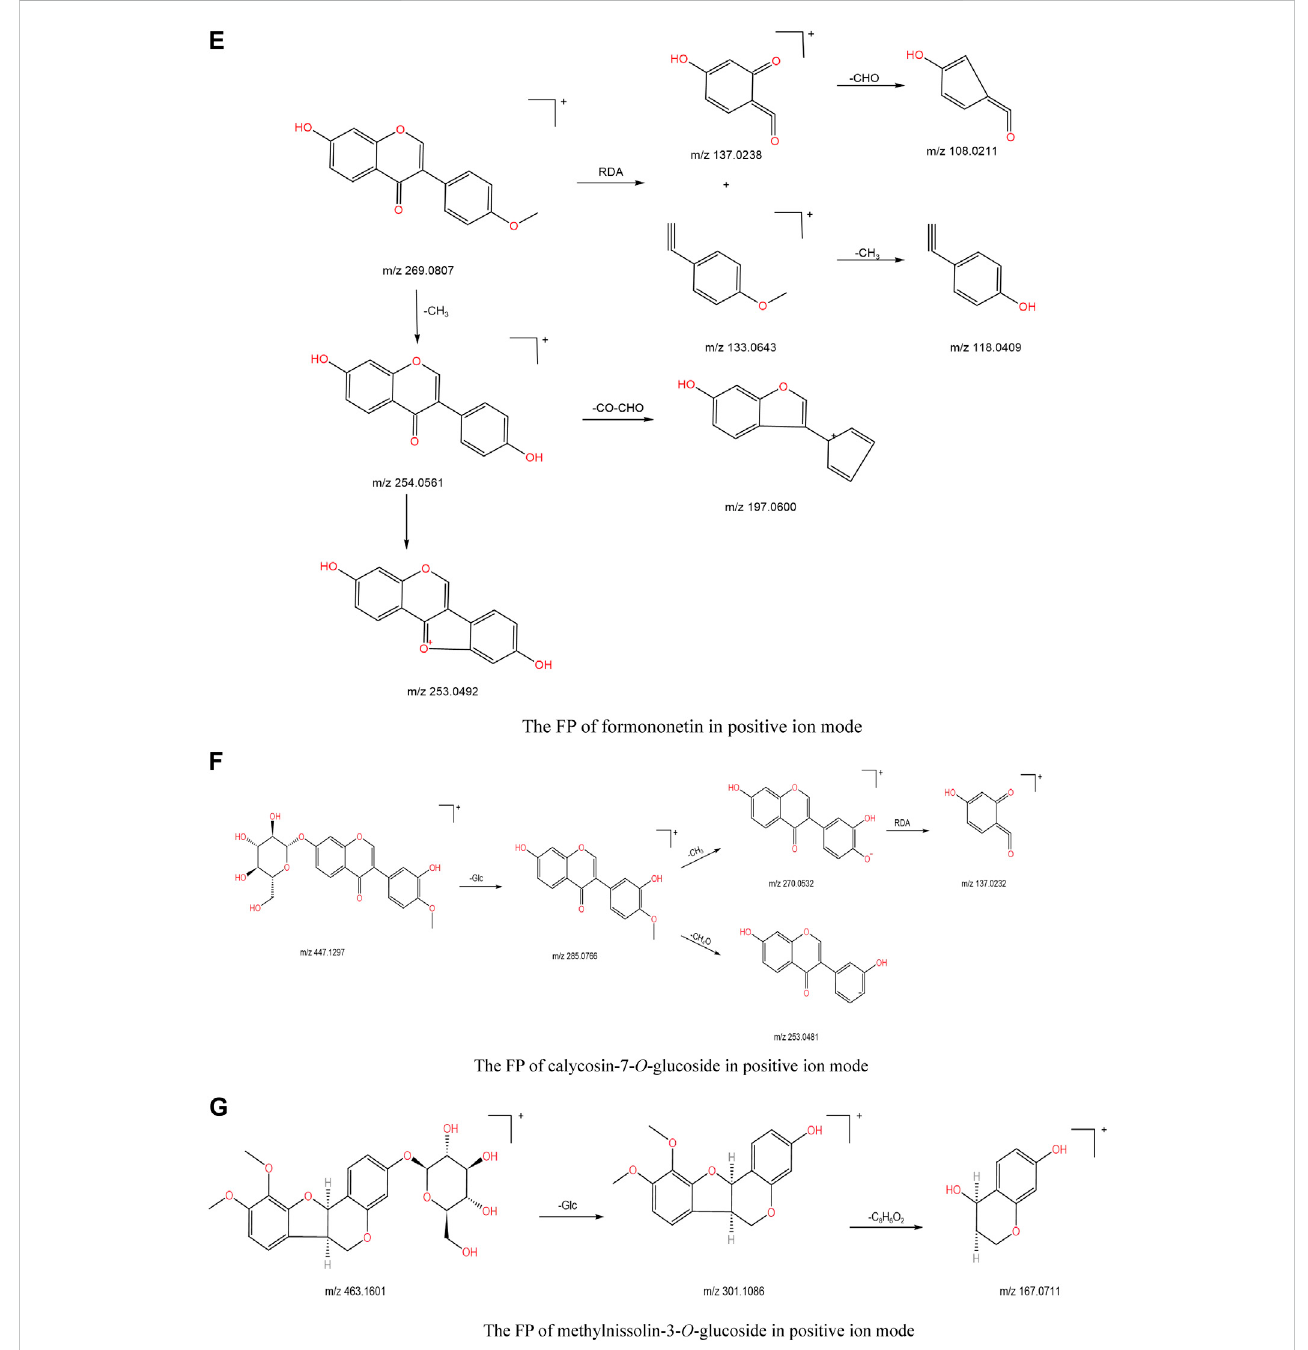
FIGURE 4 (A) TheFPofschaftosideinnegativeionmode. (B) TheFPofkumatakenininpositiveionmode. (C) Massspectrometricfragmentationofdihydro fl avones. (D) The FP of liquiritin in negative ion mode. (E) The FP of formononetin in positive ion mode. (F) The FP of calycosin-7-O-glucoside in positive ion mode. (G) The FP of methylnissolin-3-O-glucoside in positive ion mode.